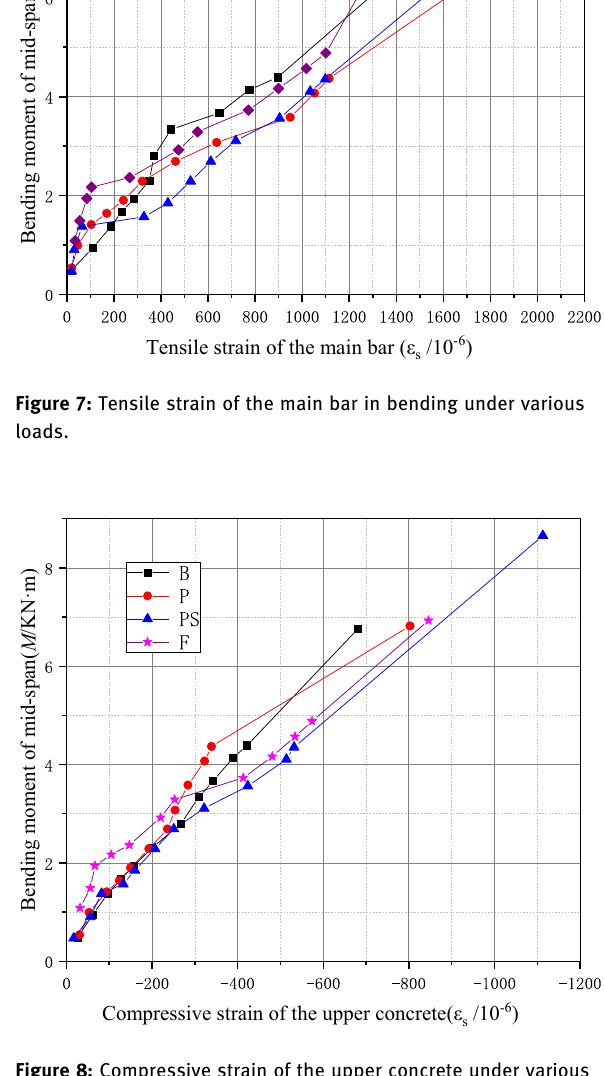
Figure 8: Compressive strain of the upper concrete under various